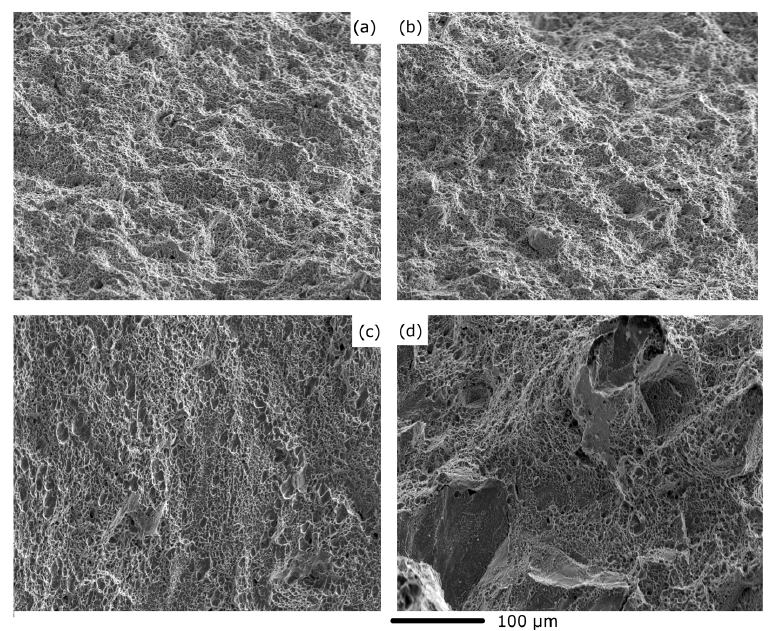
Figure A2. Fracture surfaces of samples after elevated tensile tests at 450 °C. ( a ) HT3 19; ( b ) HT5 19; ( c ) HT3 50; ( d ) HT5 50.